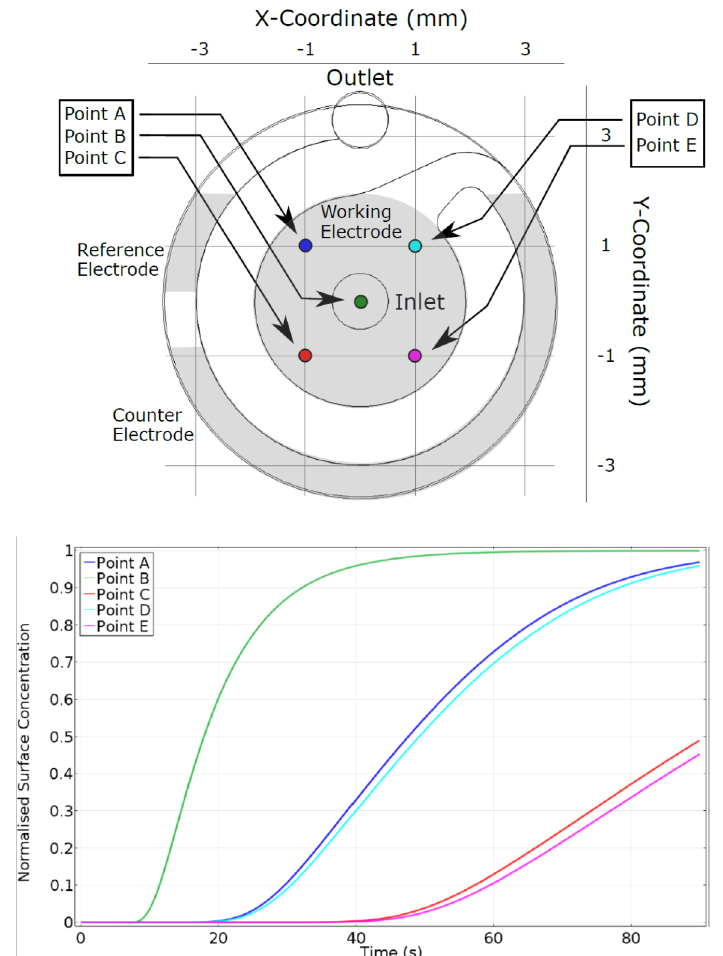
Figure 2. COMSOL simulations showing ( a ) the simulation geometry with five simulation probe points. The location of the reference, working and counter electrode at the bottom of the flow cell are shown in grey. ( b ) Evolution of concentration over time (normalized) at the five simulation points.